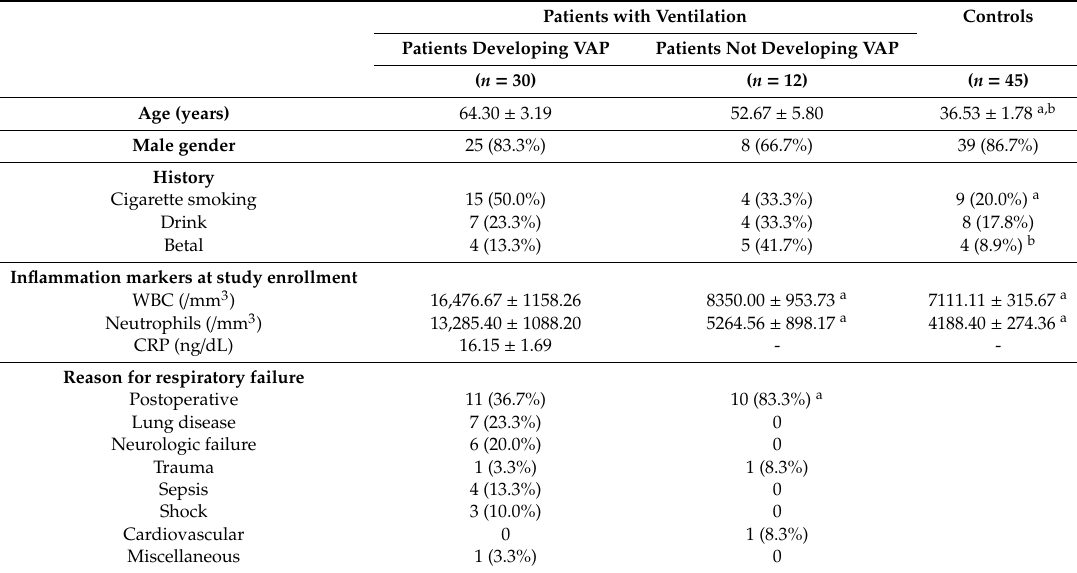
Table 1. Characteristics of ventilated patients and healthy control